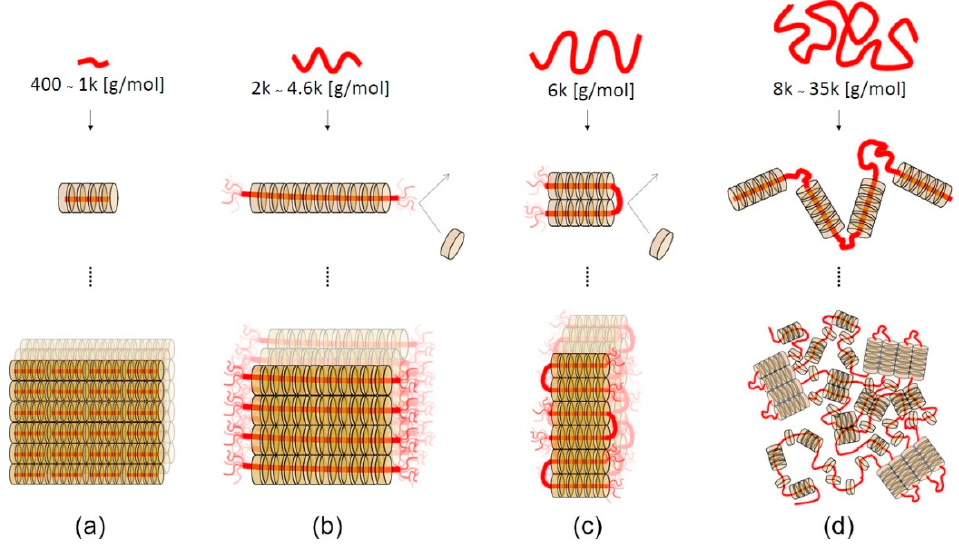
Figure 3. Schematic illustrations of polypseudorotaxane self-assembly mechanisms. ( a ) α -CDs cover the ends of PEG400–1k, and the α -CD crystal grows without limitation of the axis length. ( b ) The ends of PEG2k − 4.6k tend to be uncovered by α -CDs because of the entropic gain from the free motion of the axis, which leads to the formation of isolated polypseudorotaxanes with uniform thickness. ( c ) The axis of PEG6k folds to gain chain entropy not only at the ends but also at the folding points. ( d ) For PEG8k–35k, the axis chains fold many times, and remaining uncovered hydrophilic PEG segments give rise to hydrogels. Adapted with permission from Macromolecules 2019 , 52 , 3881 − 3887 [53]. Copyright (2019) American Chemical Society.